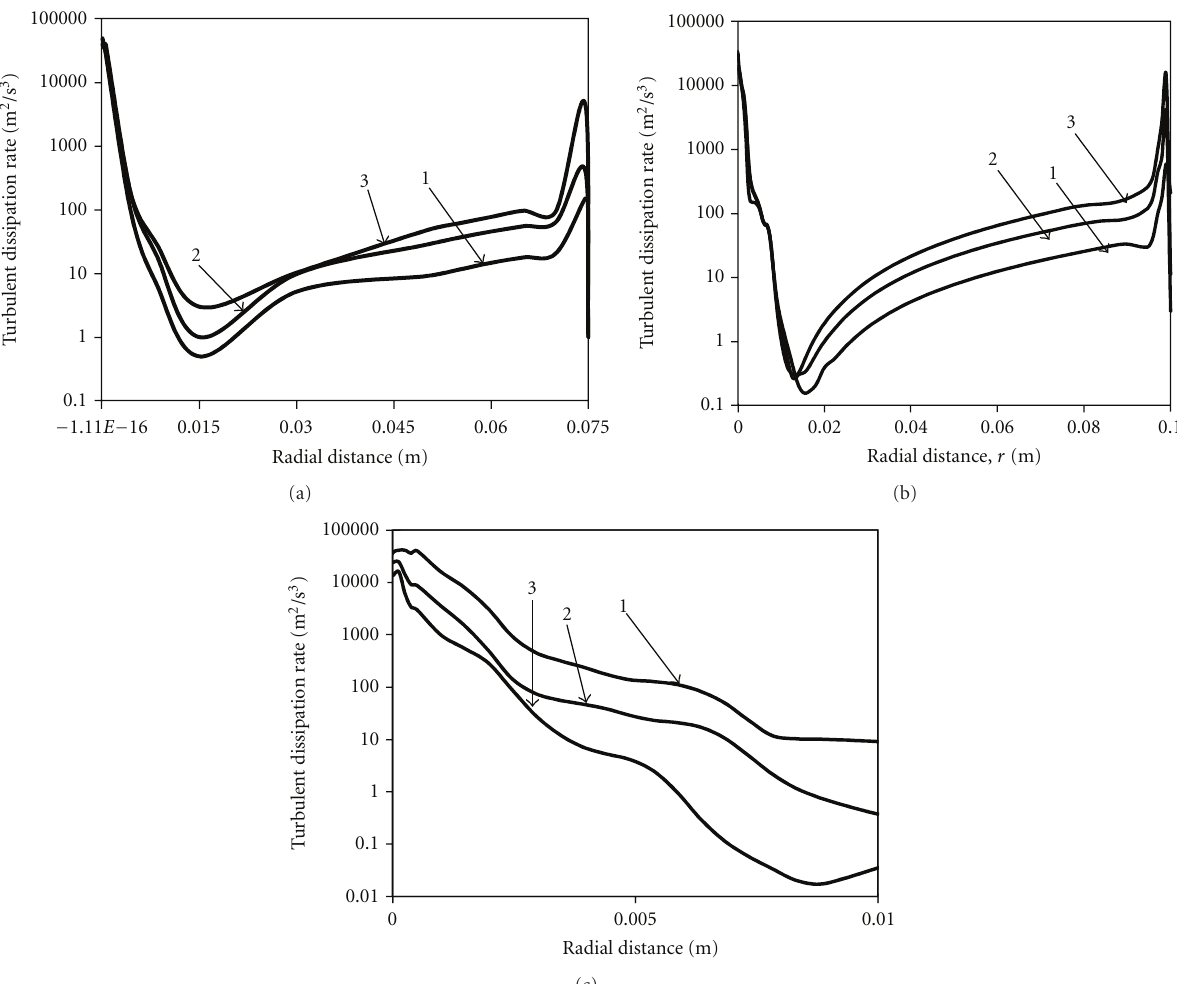
Figure 7: Variation of turbulent dissipation rate ( ε ) along radial coordinate [ z = 0 . 00075 m]. (a) Disc diameter: 0.15 m, flow rate: 300mL/min, line 1: 600 rpm, line 2: 1000 rpm, line 3: 1400 rpm. (b) Disc diameter: 0.20 m, flow rate: 300 mL/min, line 1: 600 rpm, line 2: 1000 rpm, line 3: 1400 rpm. (c) Disc diameter: 0.15 m, rotation speed: 1000 rpm,: line 1: 300 mL/min, line 2: 190 mL/min, line 3: 110